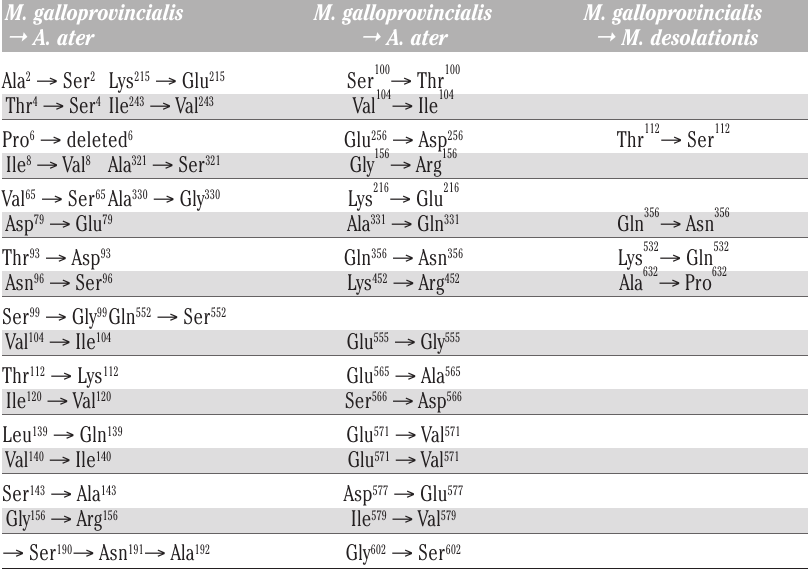
Table 3. Amino acid substitutions in hsp70 of M. desolationis and A. ater as compared to hsp70 of M.